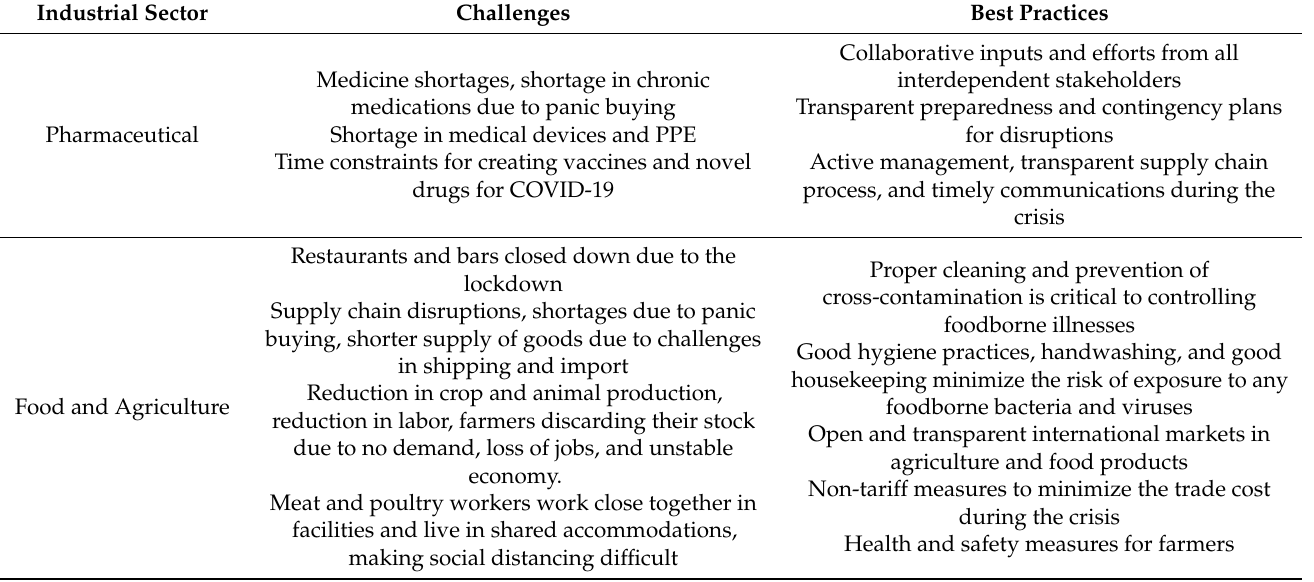
Table 1. Challenges faced by different industrial sectors during COVID-19 and best practices learned. Industrial